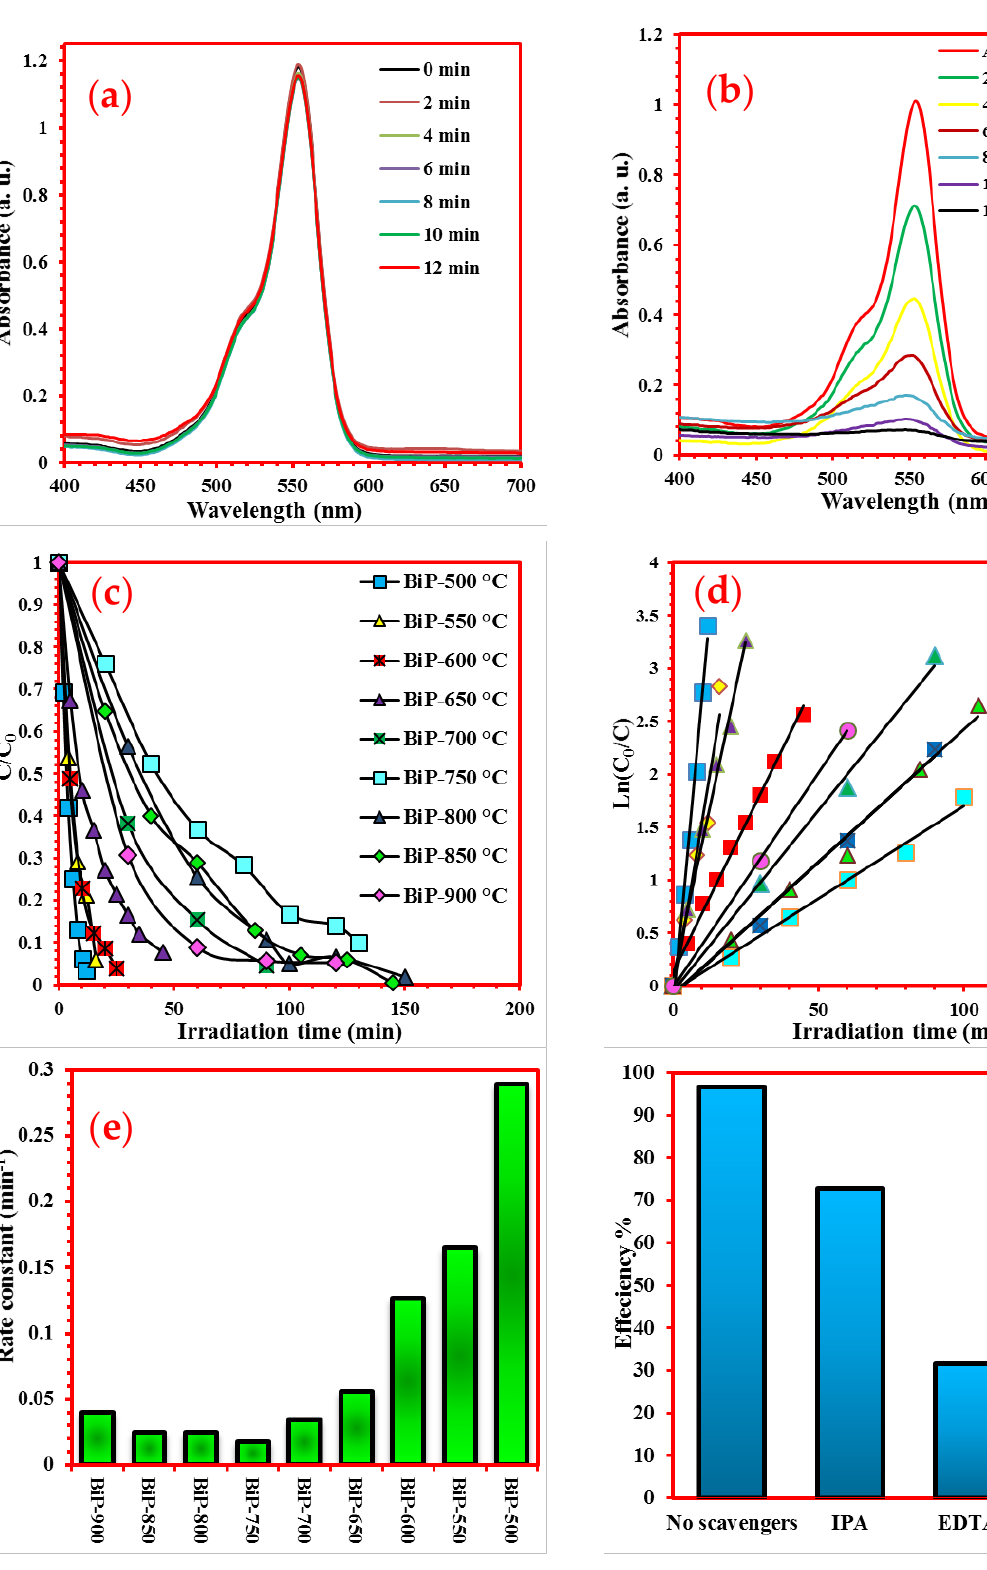
Figure 5. ( a ) Stability of RhB under UV light; ( b ) UV–vis absorption with time irradiation of a solution containing 100 mg of BiP-500 °C and 5 ppm RhB; ( c ) Degradation efficiencies of the as-prepared samples; ( d ) Pseudo-first-order kinetics of the photocatalysts; ( e ) Evolution of the apparent rate constant k as function of photocatalysts; ( f ) Effect of scavengers on the photocatalytic degradation of RhB by BiP-500.